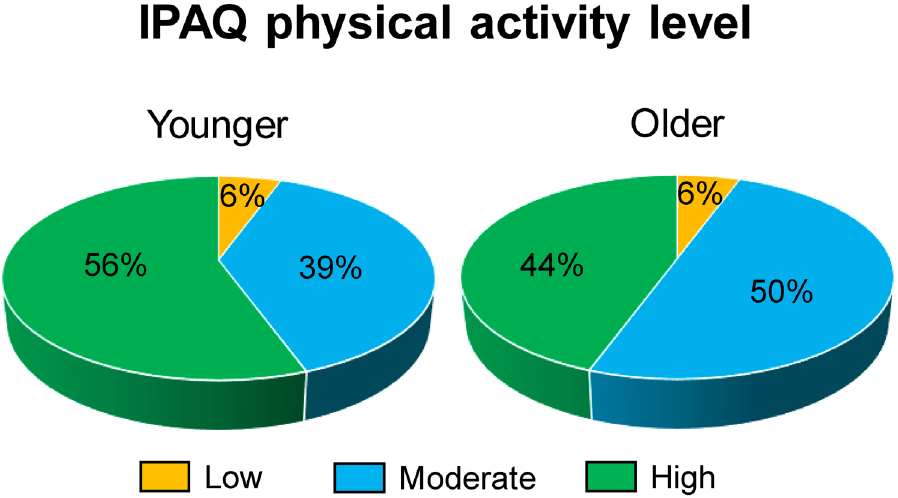
Figure 1. Distribution of participants with low, moderate and high level of physical activity divided by age.